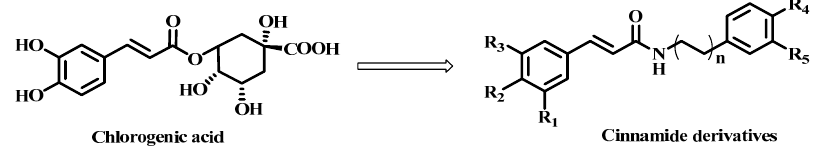
Figure 1. Design of cinnamide derivatives from chlorogenic acid.